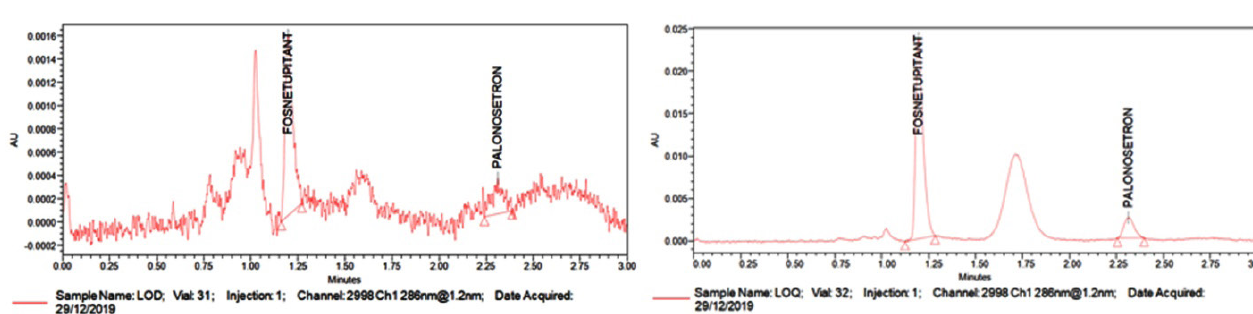
TABLE VII - Robustness data